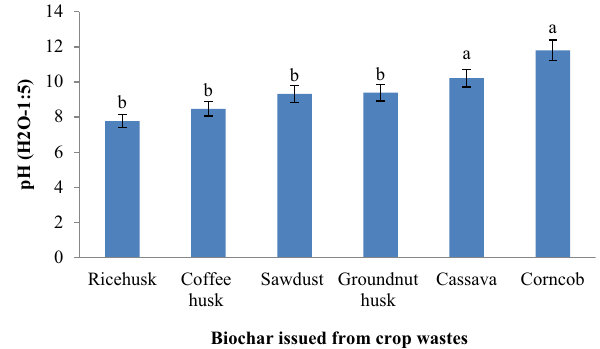
Fig. 2 pH (H 2 O) of biochar issued from crop wastes. The letters in superscript compare the mean ± SD of the treatments. The same let- ters on a bar are not significant according to Tukey test at P > 0.05 Table 5 Correlation matrix among chemical properties of crop wastes derived biochar